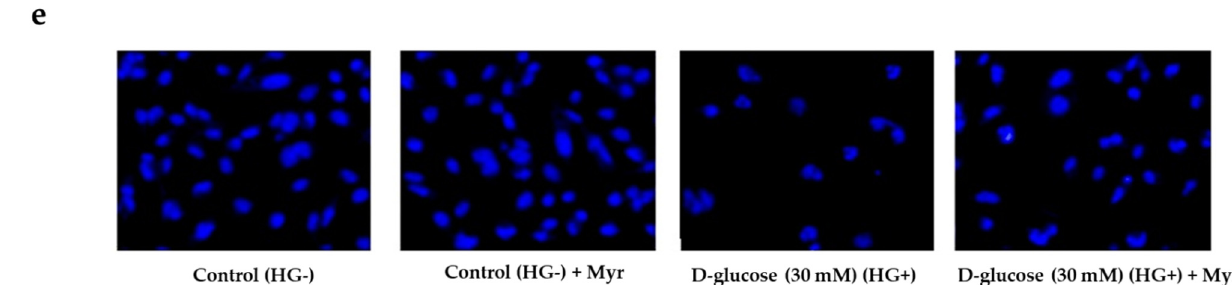
Figure 3. Cytotoxic effect of D-glucose on murine renal cells and protective effect of Myr. ( a ) Concentration dependent cytotoxic effect of D-glucose on NRK cells. ( b ) Time dependent cytotoxic effect of D-glucose on NRK cells. ( c ) Effect of Myr on the viability of NRK cells cultured in controlled (HG − ) condition. ( d ) Effect of Myr against HG-induced toxicity in NRK cells as observed in cell viability assay. ( e ) Effect of Myr against HG-induced toxicity in NRK cells as observed in Hoechst nuclear staining. HG caused loss of cell viability of NRK cells in both concentration and time dependent manner. Myr culture in HG-condition did not affect cell viability. Myr reciprocated HG-induced loss of cell viability as seen in cell viability assay and Hoechst nuclear staining. Data are represented as the mean ± SD, n (number of plates) = 3. $ Values significantly ( p < 0.05) differed from the control (HG − ) group. # Values significantly ( p < 0.01) differed from the control (HG − ) group. ** Values significantly ( p < 0.01) differed from the HG-treated (HG+) group.